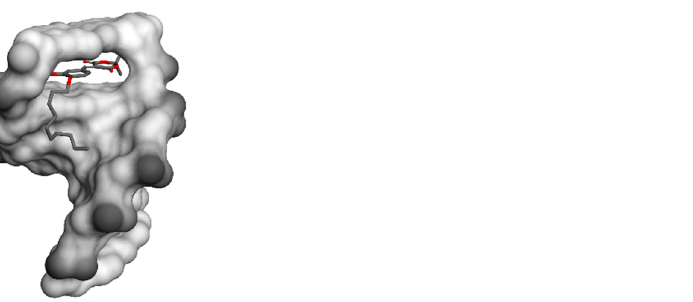
Figure 1. Structures of compounds 3e , 3h , and 3i .